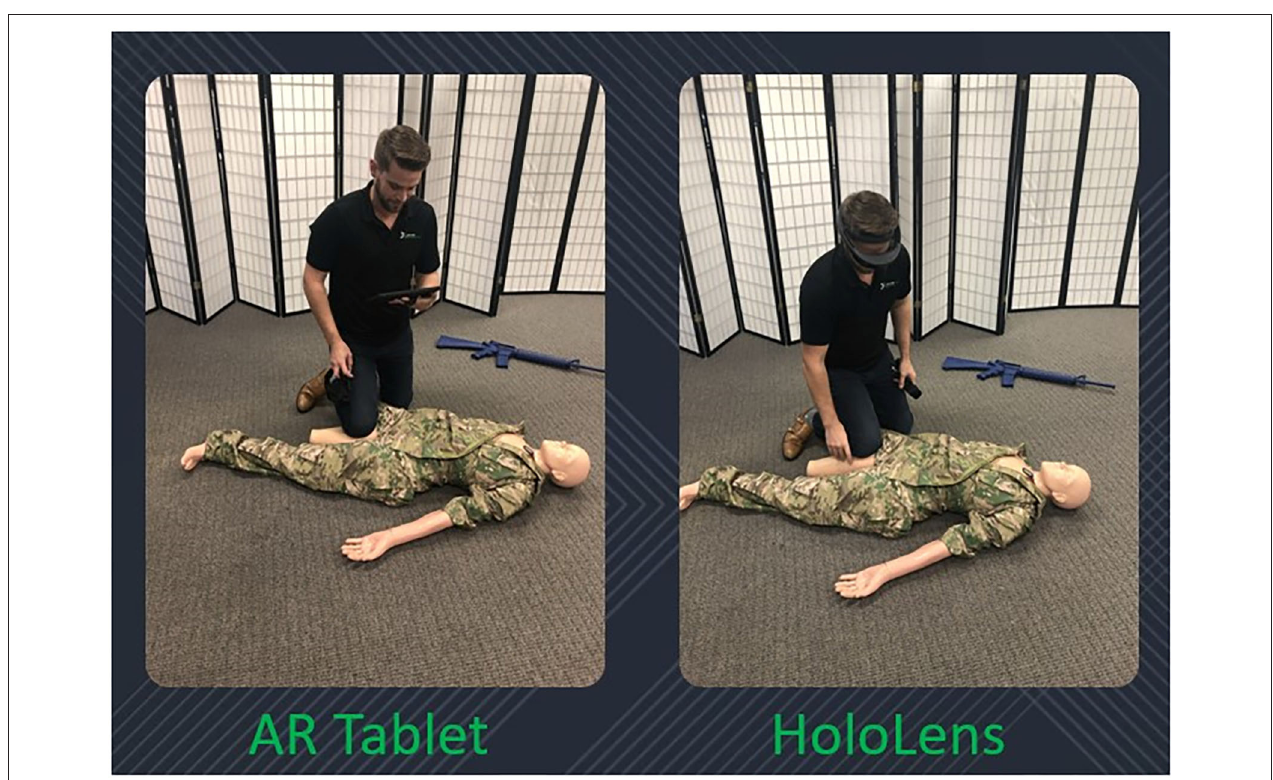
FIGURE 1 | Display type, HoloLens vs. AR